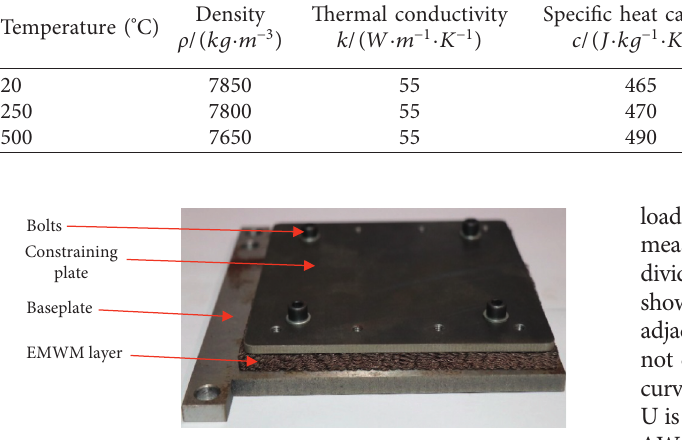
Figure 4: Image of the cantilever composite structure with EMWM